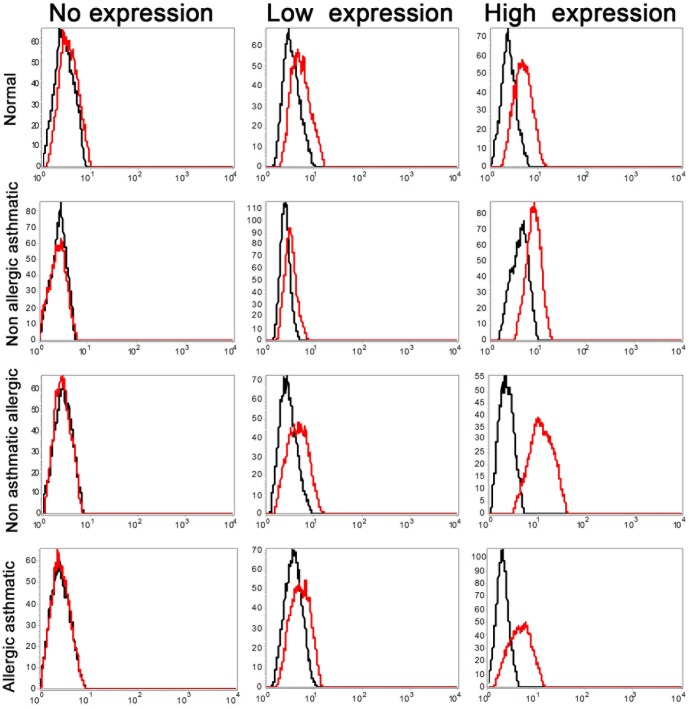
Cell surface expression of leptin receptor on peripheral blood PMNs.Highly purified peripheral blood children PMNs from allergic asthmatics, non-asthmatic allergic, non-allergic asthmatic, and normal controls were analyzed by FACS with mouse anti-human leptin mAb(red lines) and mouse IgG2a isotype-matched control Ab (black lines).